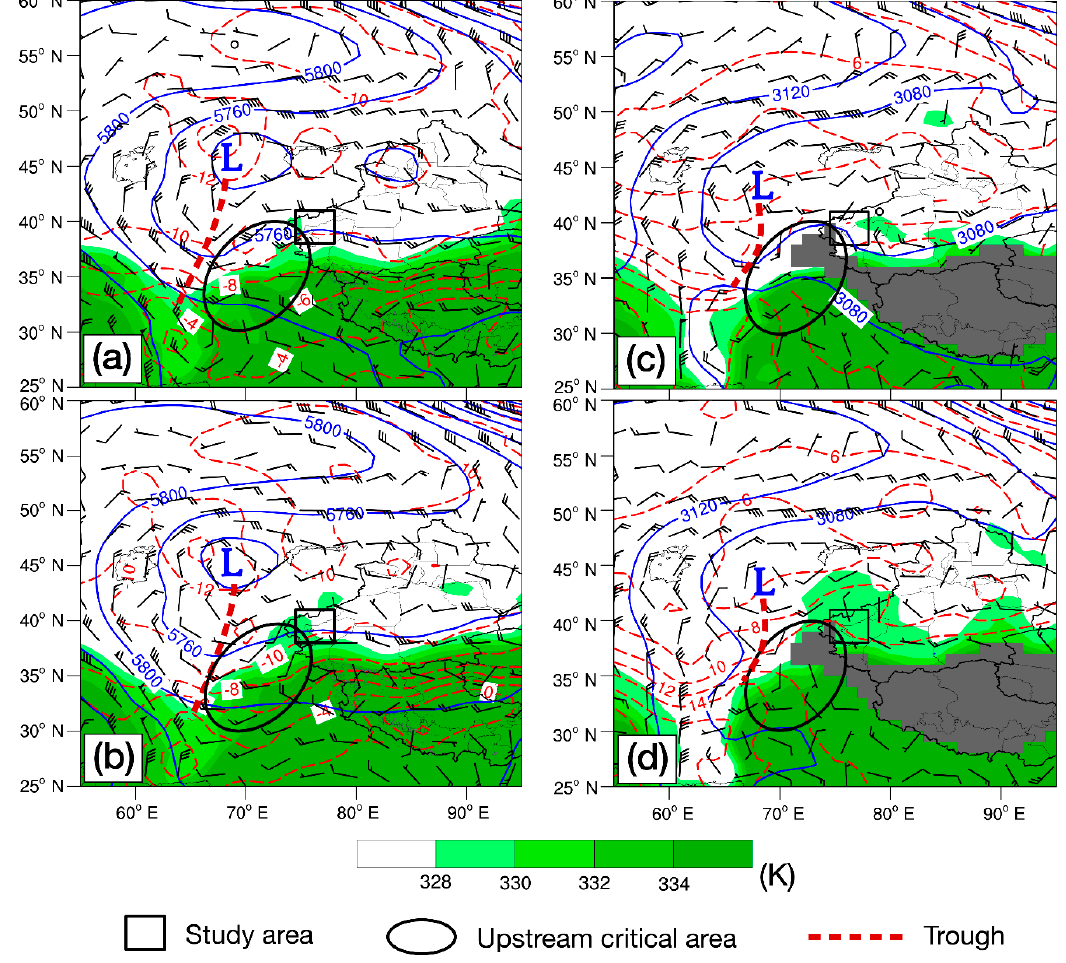
Figure 2. ( a , b ) Equivalent potential temperature ( θ e , green shading; unit: K) in excess of 328 K, geopotential height (blue solid contours; unit: gpm), temperature (red dashed contours; unit: ◦ C) and wind field (half barbs; full barbs and flags represent 2, 4 and 20 m · s − 1 , respectively) at 500 hPa on 23 June 2015. ( c , d ) are the same as ( a , b ), but for the values at 700 hPa; the gray shading represents for the Tibet Plateau with ground pressure below 700 hPa. The specific time is shown in the upper right corner of each